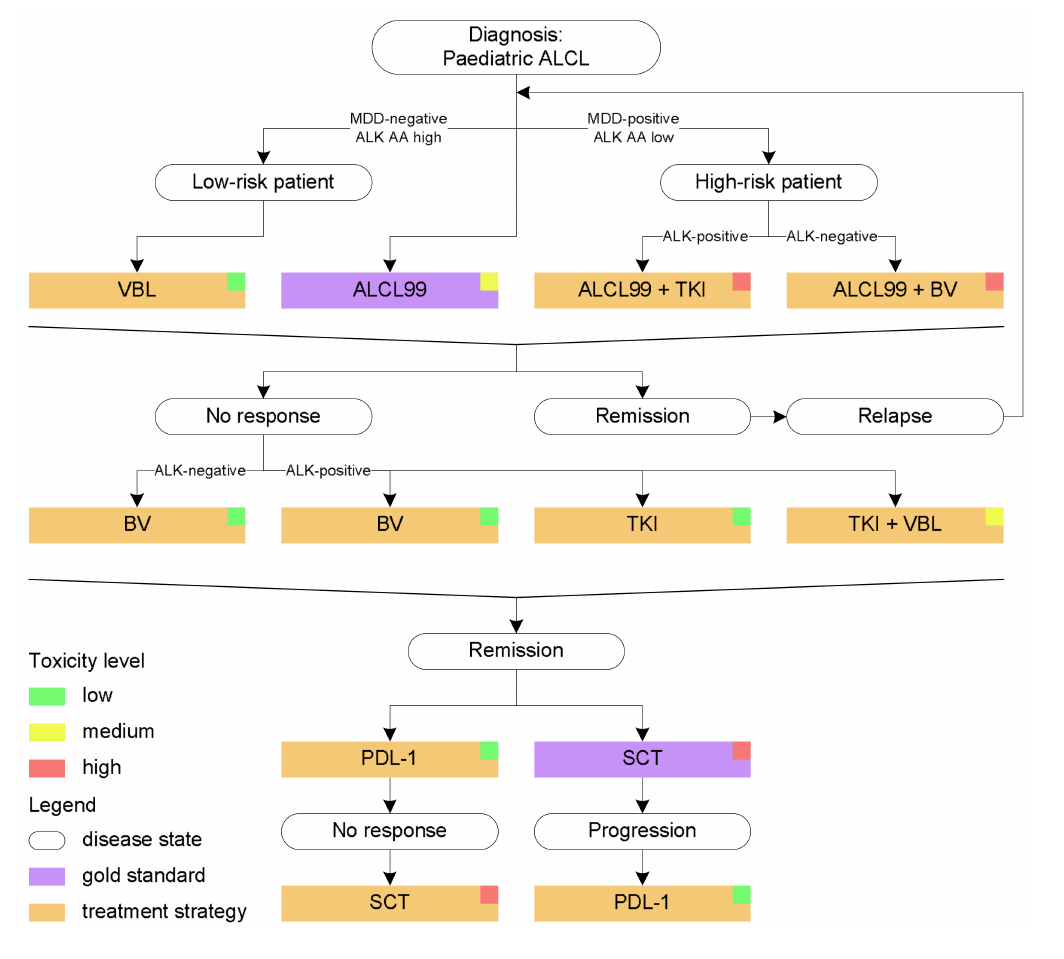
Figure 1. Management of childhood Anaplastic Large Cell Lymphoma (ALCL). ALK AA = ALK auto-antibody; BV = brentuximab vedotin; MDD = minimal disseminated disease; SCT = stem cell transplantation; TKI = tyrosine kinase inhibitor; VBL =